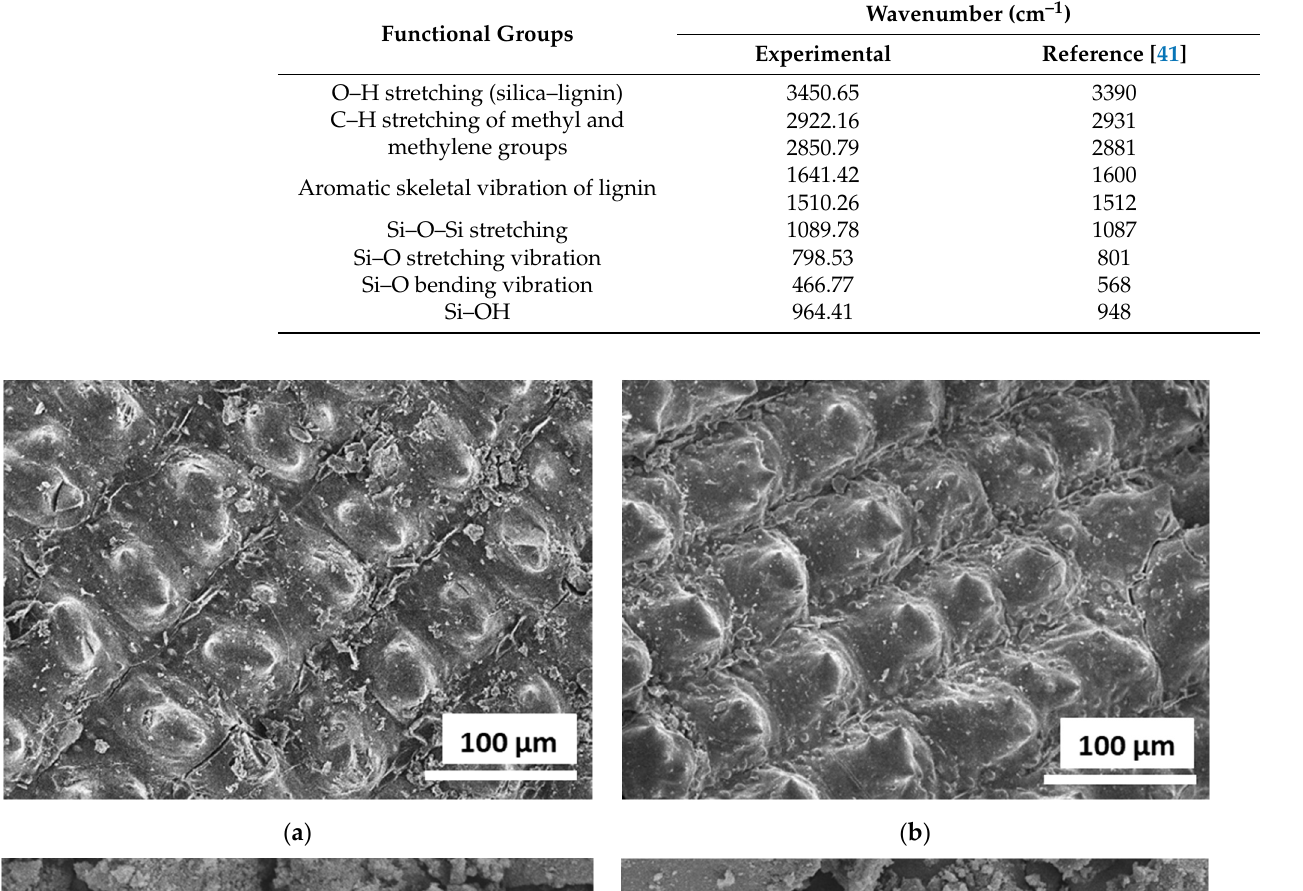
Table 3. The functional groups of the extracted silica–lignin hybrid.